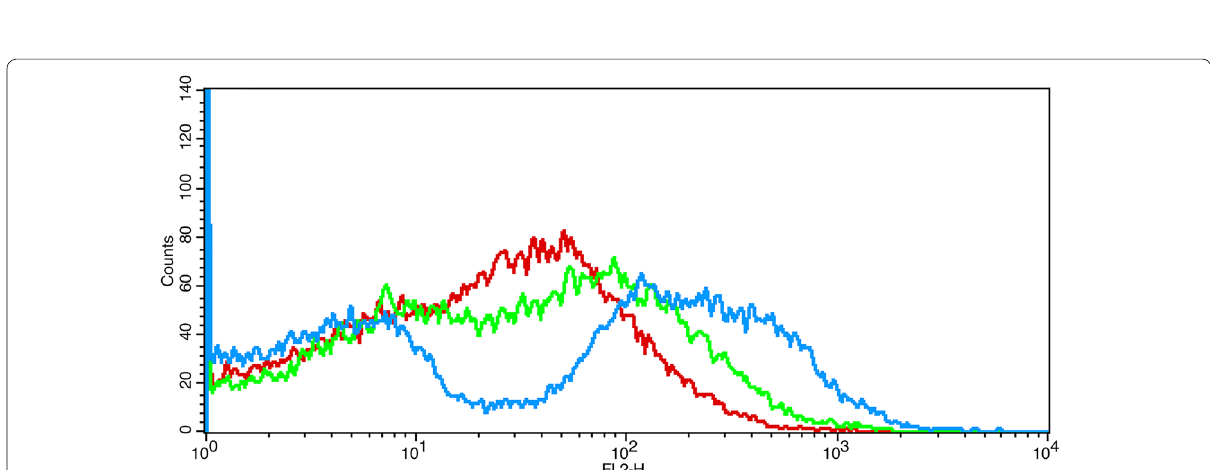
Fig. 5 Cell viability was detected by flow cytometry of A. niger sp. ZJUY cells, grown on methanol ( blue-broken line ), SVH ( green-broken line ), and methanol supplemented with SVH ( red-broken line